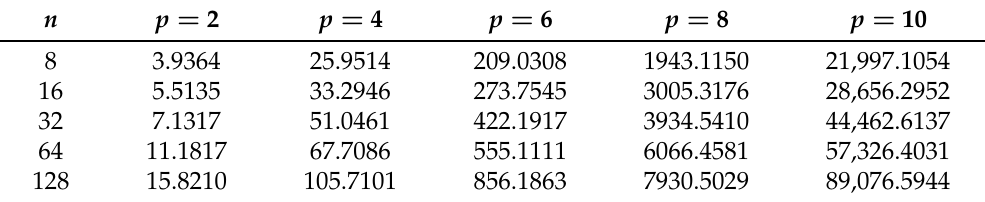
Table A4. Execution time (ms) of PDIST . GetDistance operation on desktop